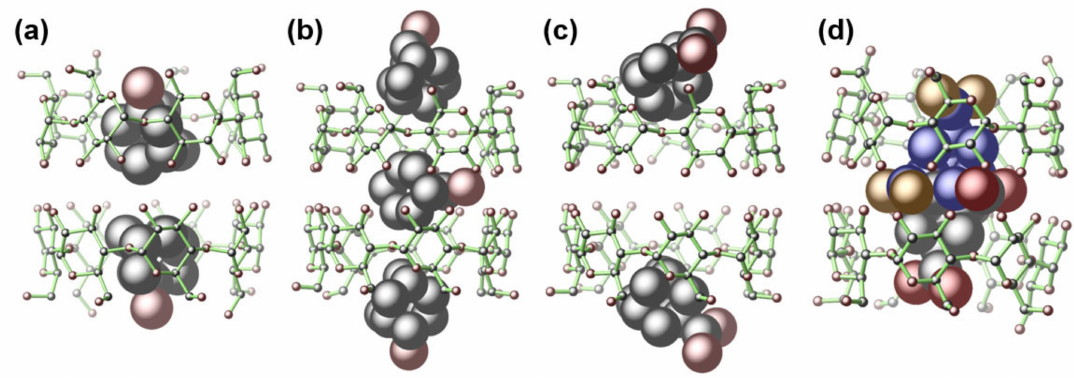
Figure 3. The X-ray crystal structures of 1 ( a ), 2 ( b ), 4 ( c ), and 5 ( d ) showing different adamantane-to- β -CD ratios and diverse guest orientations in the inclusion complexes. The guests are presented as a space-filling model. The hydrogen atoms are omitted for clarity. Color codes: O (brown-red), C (black). For 5 , the two disordered parts of adm-1,3-diCOOH are represented by blue (for C) and brown (for O), as well as gray (for black) and brown-red (for O).